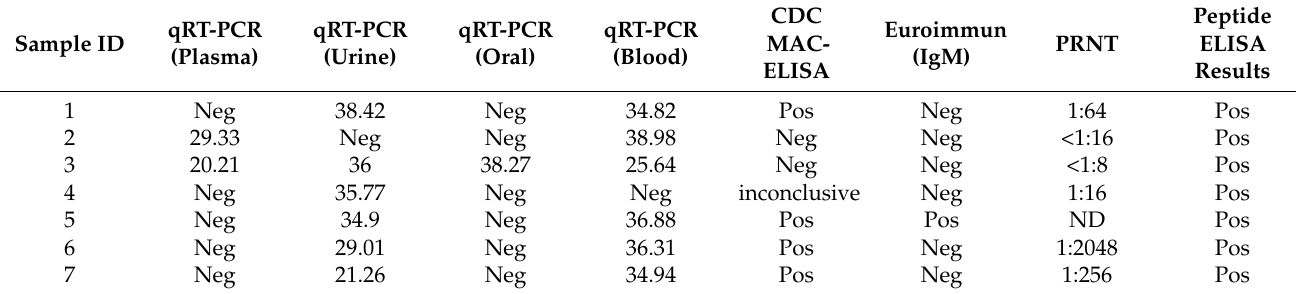
Table 3. Comparison of peptide-based ELISA to nucleic acid and serological assays.